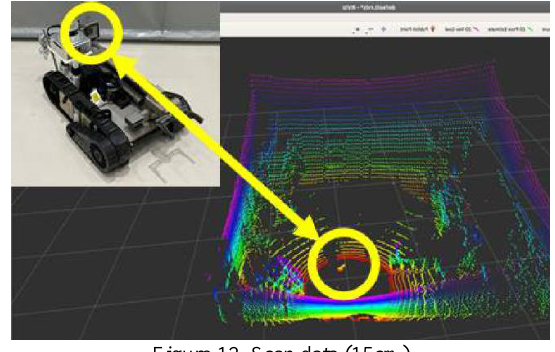
Figure 12. Scan data (15cm)